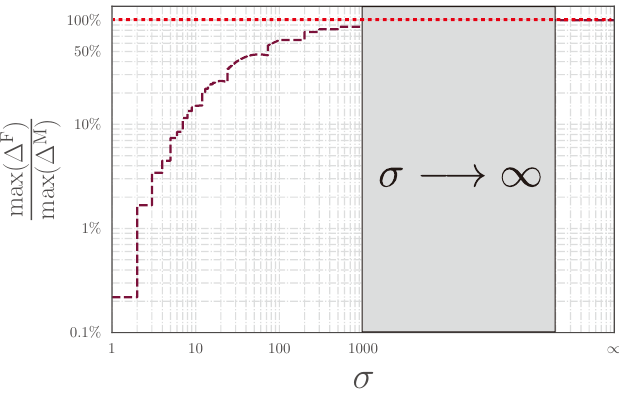
Figure 5 . The step plot of the fraction of the maximum value of ∆ F to the maximum value of ∆ M versus σ . When σ . O (10) , the corresponding GW spectrum is significantly influenced by the expansion of the universe. Even when σ ∼ 100 , the GW spectrum is still be depressed by 50 % compared to the results estimated in Minkowski spacetime. When σ increases, this ratio increase as well and will finally converge to 100% when σ → ∞ , in which regime the expansion of the universe can be totally